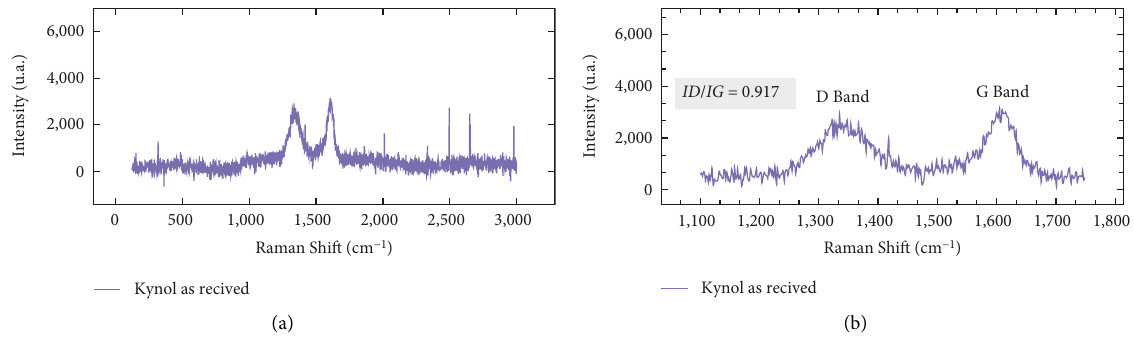
Figure 6: Kynol Raman spectroscopy in (a) and zoomed in (b) with D and G bands